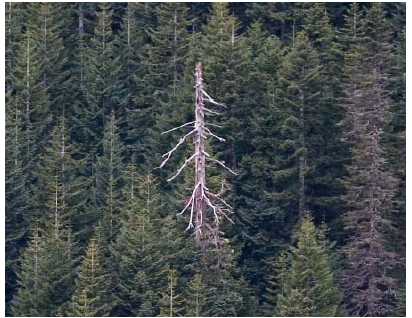
Figure 1 Snags in a forest area (cropped out from Wiki) Tree crowns are typically derived with the watershed algorithm (Pyysalo et al., 2002), or by a region growing (Solberg et al., 2006) on the crown height model (CHM). Novel methods